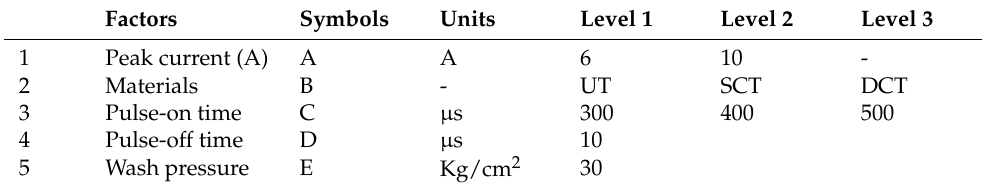
Table 2. Test factors and levels.